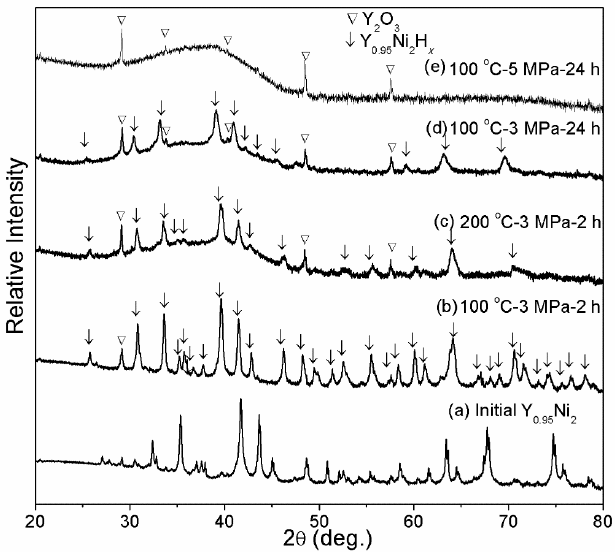
Figure 3. XRD patterns of Y 0.95 Ni 2 after hydrogenation under different temperatures, hydrogen pressure, and times. ( a ) Initial Y 0.95 Ni 2 ; ( b ) 100 ℃ -3 MPa-2 h; ( c ) 100 ℃ -3 MPa-2 h; ( d ) 100 ℃ -3 MPa-24 h; ( e ) 100 ℃ -5 MPa-24